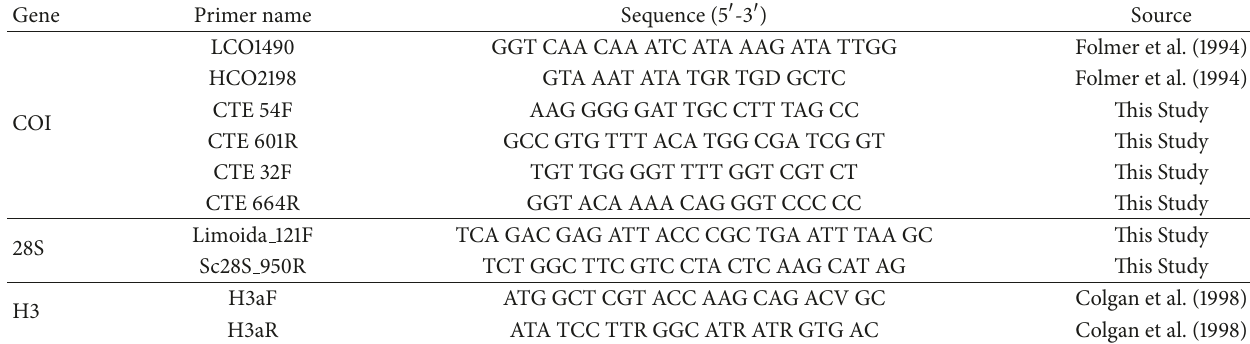
Table 1: PCR primers used for gene amplification on Ctenoides scaber and C. mitis .